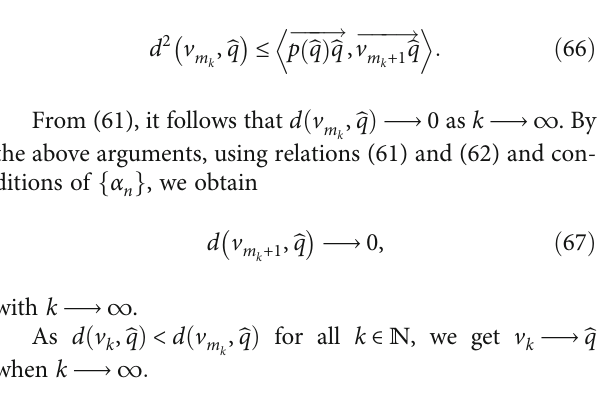
− w k generated by Algorithm and k v n n n